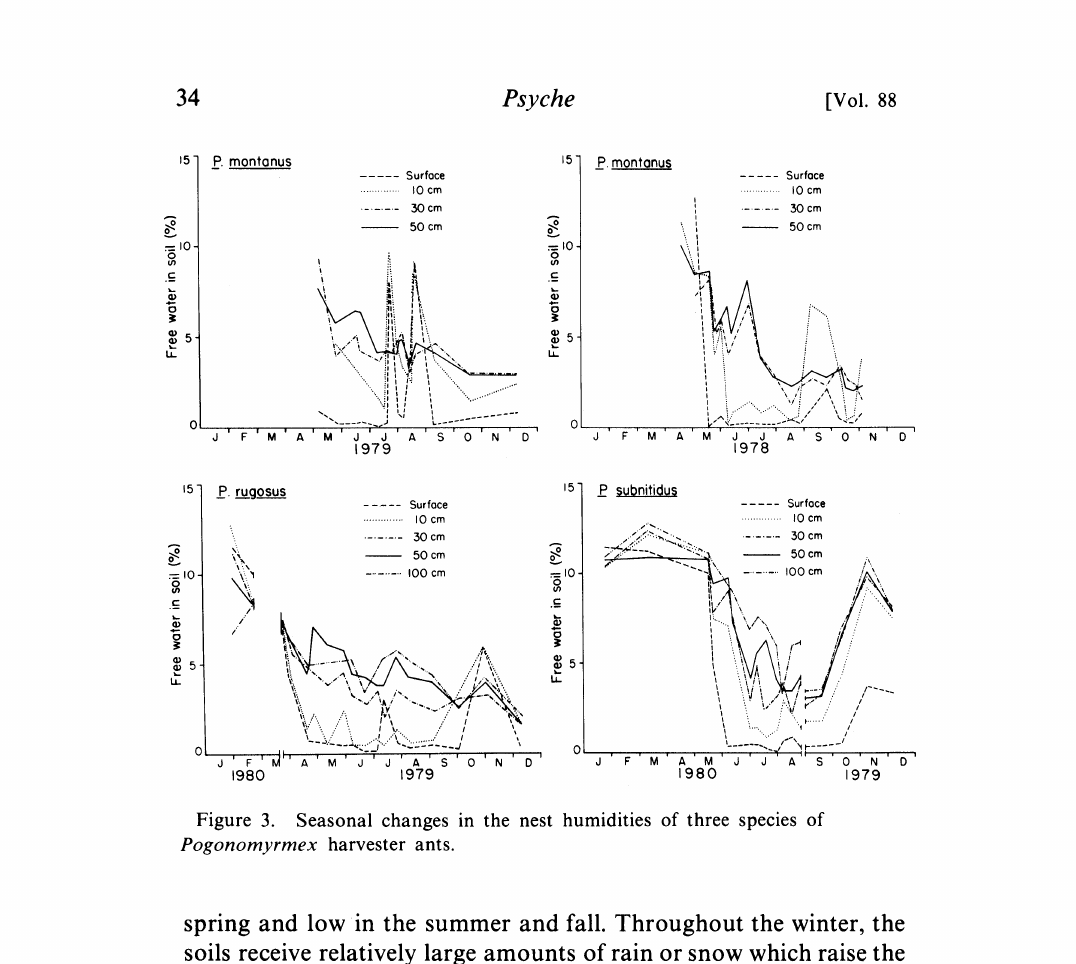
spring and low in the summer and fall. Throughout the winter, the soils receive relatively large amounts of rain or snow which raise the soil moistures to high levels. After this time, the surface and upper levels lose water rapidly by evaporation. The lower levels of the nest retain water throughout the entire season, although the percentage decreases. Soil moistures at levels below 30 cm are essentially the same for all three species. Summer showers rapidly increase soil moistures of the upper levels (note the peaks in the Figure 3), but have little effect on the levels below 30 cm. This water input into the soil is rapidly lost by